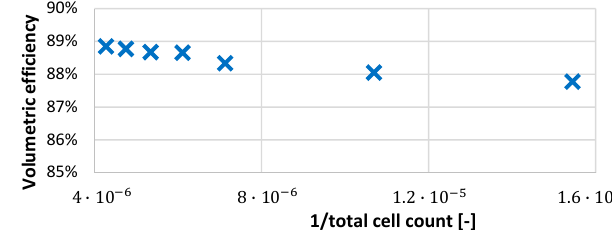
Figure 7. Dependence of the volumetric efficiency on the total cell count N in the rotor region.